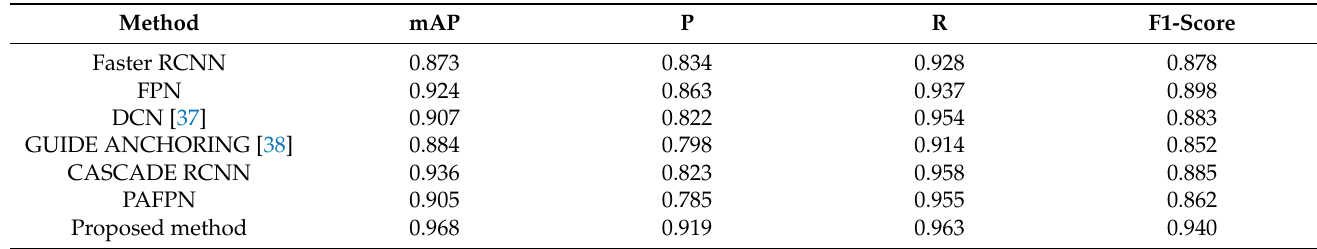
Table 5. Comparison results of the other state-of-the-art CNN-based